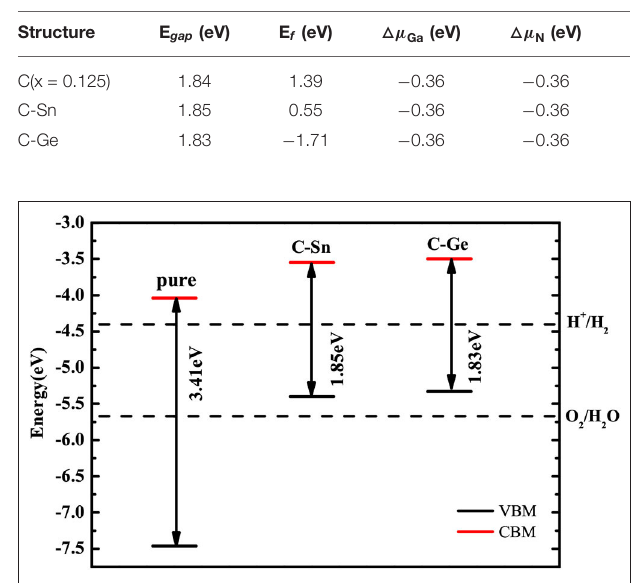
FIGURE 6 | The calculated VBM and CBM positions of pure and codoped GaN nanosheets with respect to the water redox